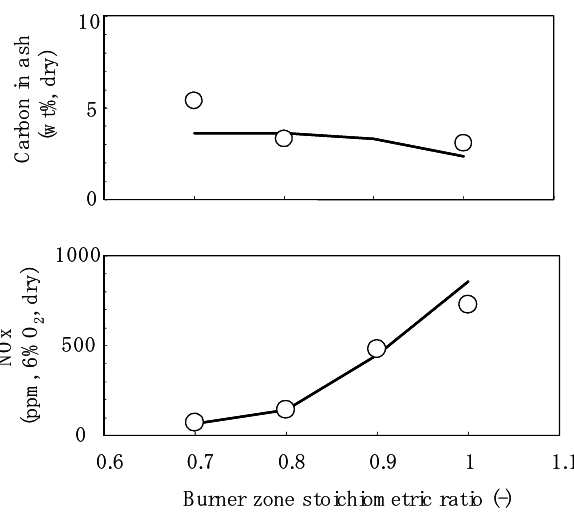
Figure 6. Staged combustion properties of coal K. Exit stoichiometric ratio was 1.2. Burning temperature was 1873 K for the burner zone and 1673 K for the staged combustion zone. Residence time was around 1.4 s for the burner zone and around 1.0 s for the staged combustion zone. Symbols are experimental and lines are calculated